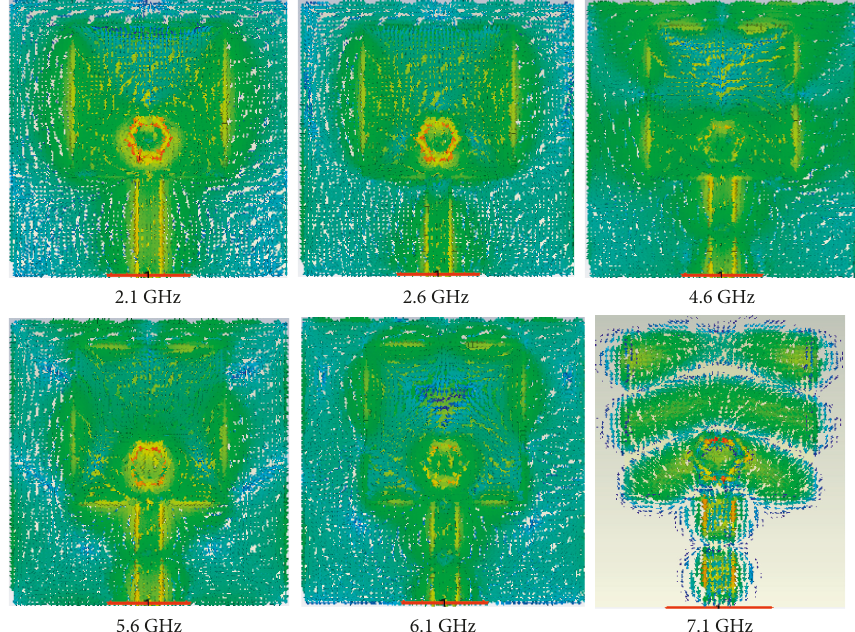
Figure 10: Surface current density plot at various resonating